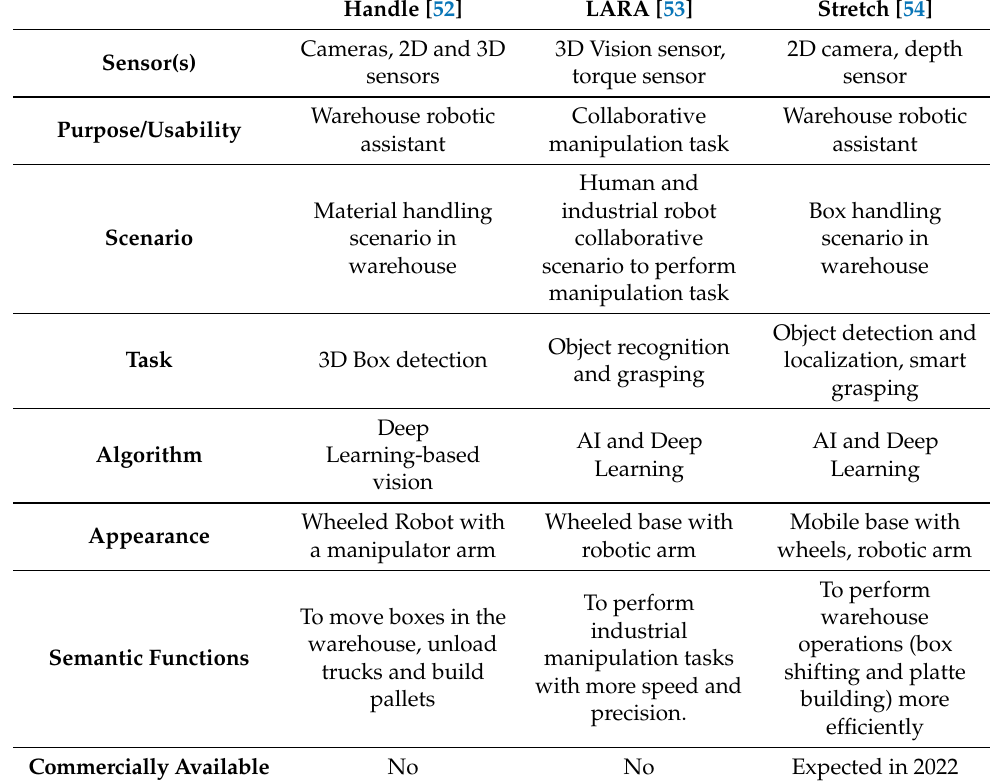
Table 6. Robots in Industrial